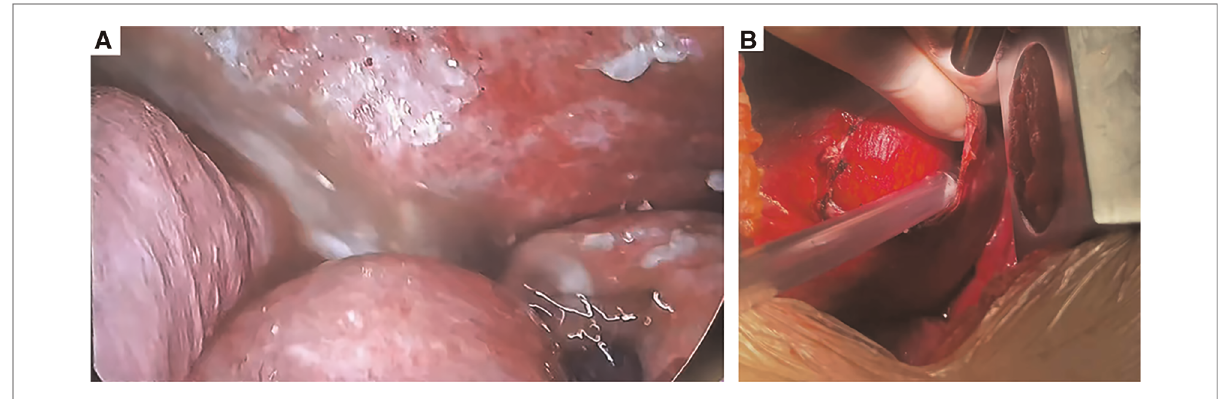
FIGURE 3 Intraoperative fi ndings of the second operation. ( A ) Contamination of the thoracic cavity with stomach contents. ( B ) Intraoperatively, a 6-cm- diameter diaphragmatic defect was